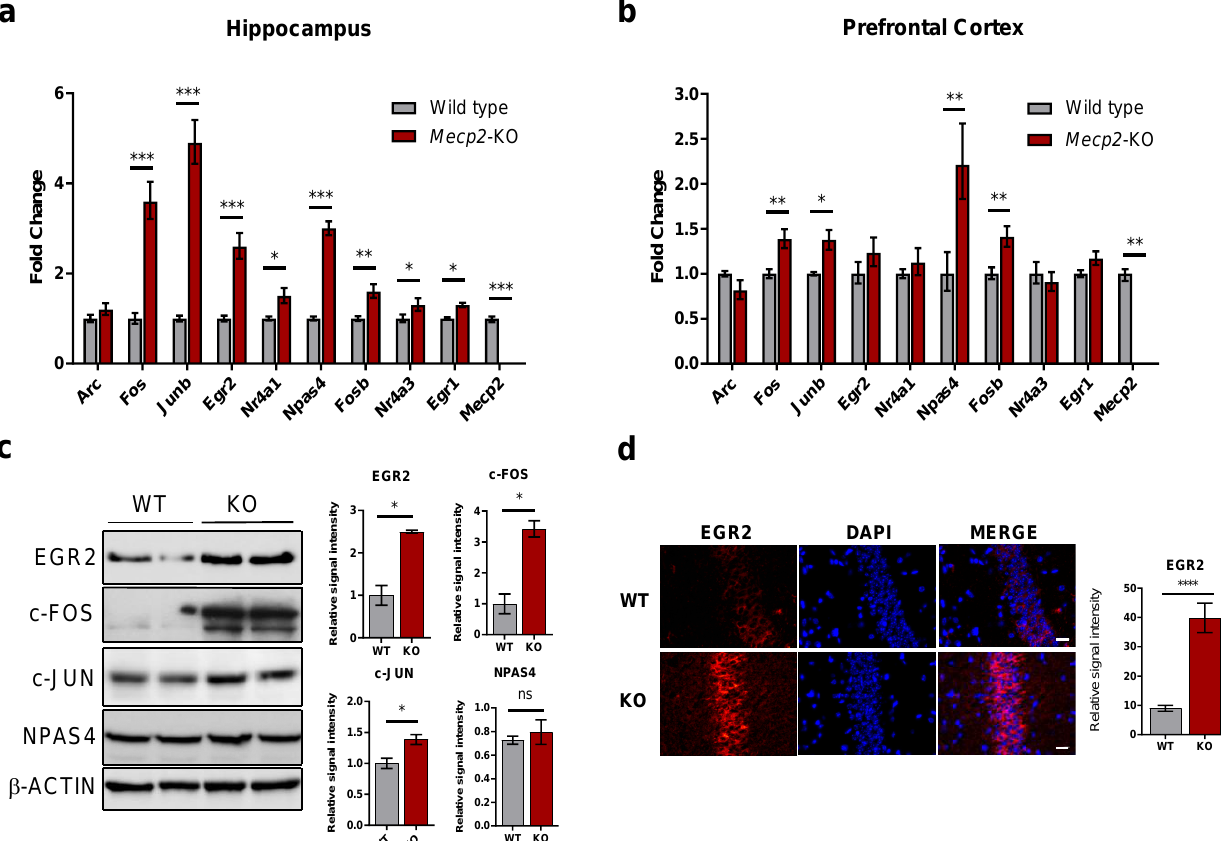
Figure 1. Validation of IEGs expression in Mecp2 -null mice. ( a , b ) IEGs expression in the hippocampus and prefrontal cortex of 8-weeks mice. Graphs show mean ± SEM of n = 5–6 animals per condition. Student’s t -tests were used (* p < 0.05, ** p < 0.01, *** p < 0.001). ( c ) Western Blot analysis of EGR2, c-FOS, c-Jun and NPAS4 in the hippocampus of 8-weeks mice. β -ACTIN was used as loading control. Samples from two animals per condition are shown. Graphs on the right represent quantitation of band intensity (mean values ± SEM, two tailed Mann-Whitney test, * p < 0.05, ns = not significant). ( d ) Representative immunostaining of EGR2 protein (red) in the hippocampal regions of WT or Mecp2 -KO 8-week mice, counterstained with DAPI (blue). All images were processed with ImageJ Fiji version 1.50 g. Scale bar represents 200 µm. The graph corresponds to quantitation of n = 10 images per condition (mean values ± SEM, two-tailed unpaired t test, **** p < 0.001).